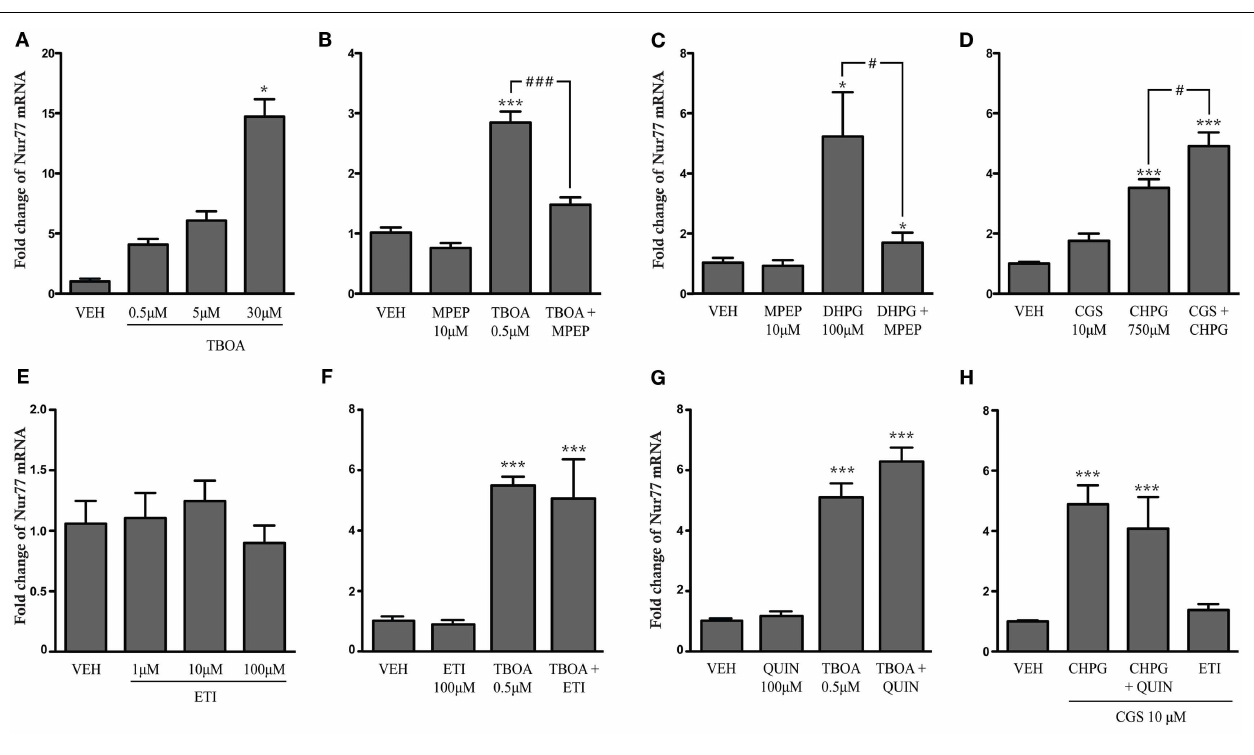
selective mGlu5 receptor agonist), and CGS + CHPG ( N = 5; *** p < 0.001 vs.VEH; # p < 0.05 vs. CHPG group), ( E )VEH or increasing doses of the D 2 receptor antagonist eticlopride (ETI; N = 6), ( F )VEH, quinpirole (QUIN, a dopamine D 2 receptor agonist),